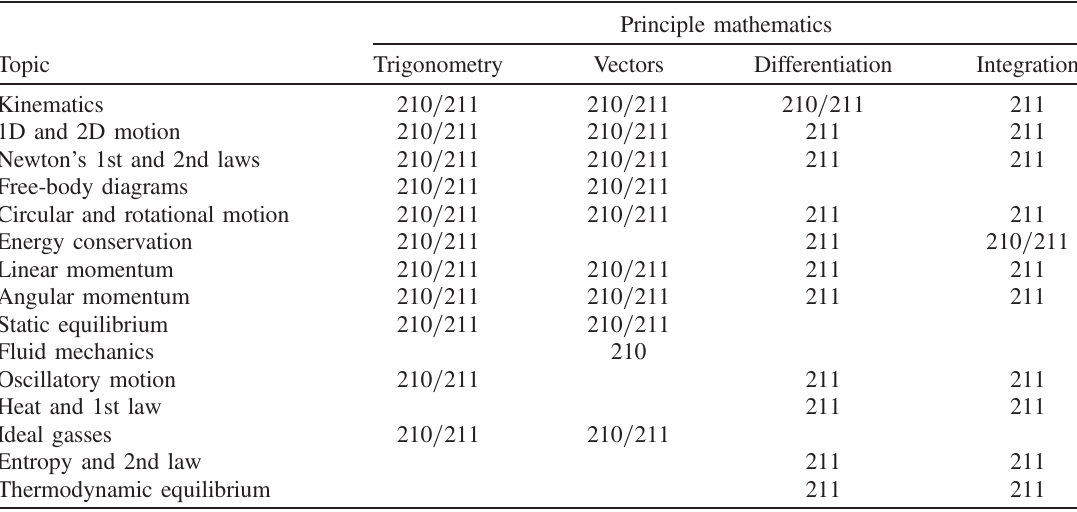
TABLE I. Mathematics tasked to students for each topic in PHSX 210 [18] and PHSX 211